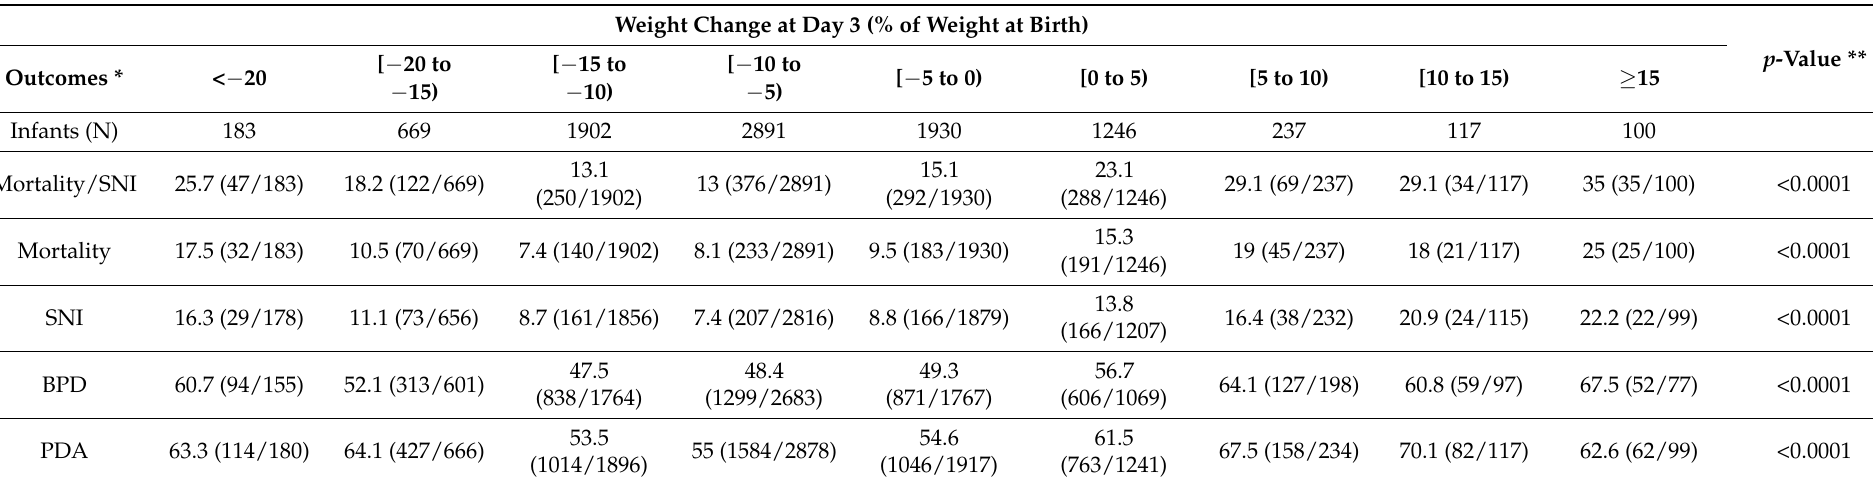
Table 3. Association of weight change at day three of age (% of birth weight) and short-term neonatal outcomes. Weight Change at Day 3 (% of Weight at